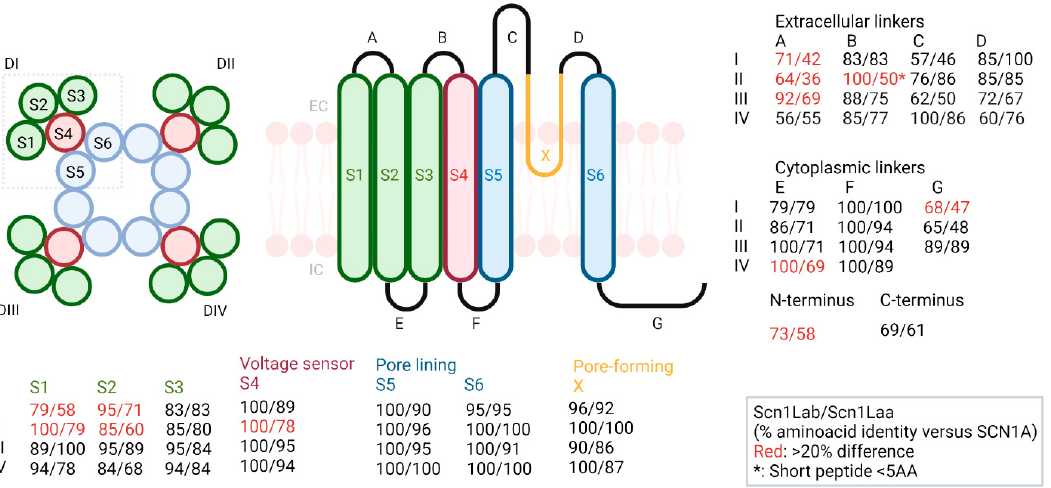
Figure 2. Top-down and horizontal structure of VGSC and multiple sequence alignment of Scn1laa:SCN1A and Scn1lab:SCN1A. Scores are percentage amino acid identity of Scn1lab/Scn1laa versus SCN1A. Roman letters indicate Domain I, II, III and IV, S1–S6 = transmembrane segment 1–6, A–D extracellular loops, E–G cytoplasmic linkers. Regions with more than 20% difference are highlighted in red. Short peptides are marked with an